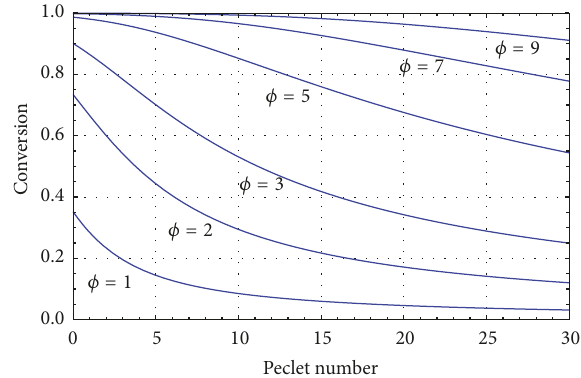
Figure 8: Simulation of conversion versus convective flow (Peclet number) at different values of reaction modulus.